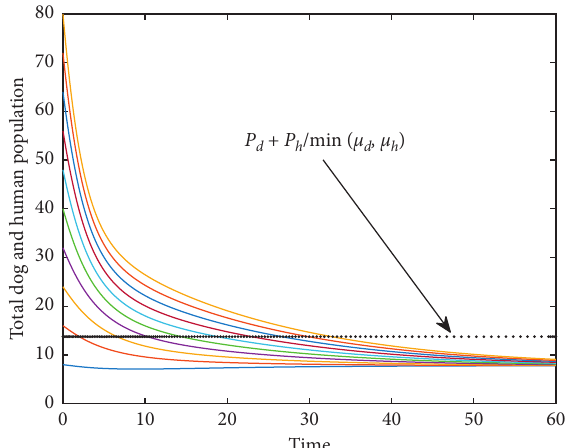
Figure 3: Simulation of the model illustrating the boundedness of solutions of model (1) (Theorem